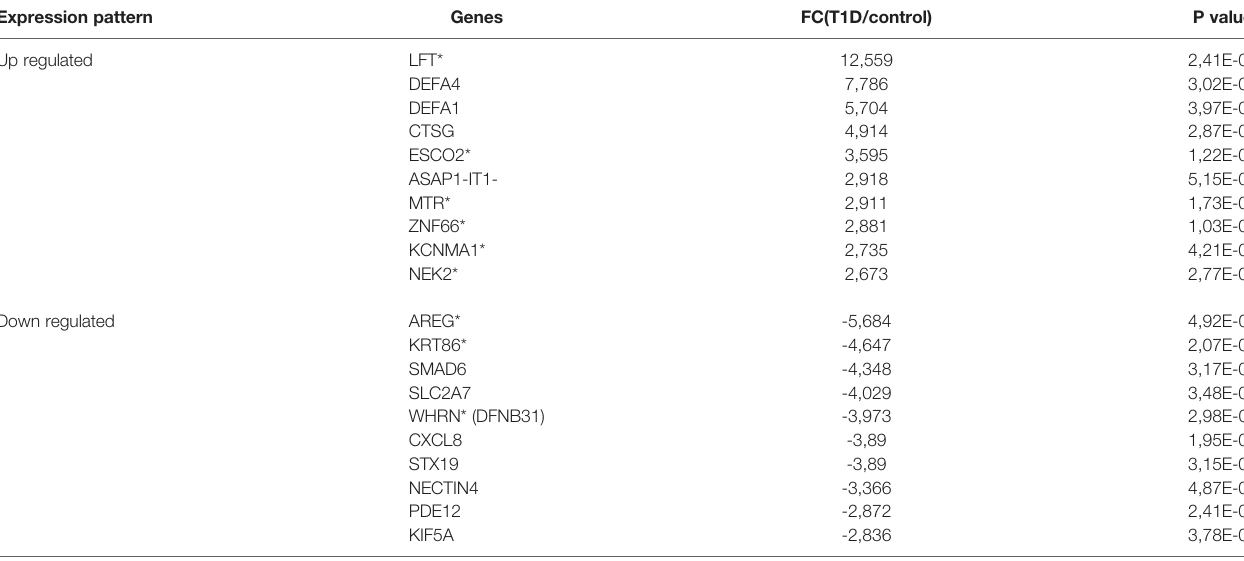
TABLE 2 | Expression (#) of top 10 up-regulated and down-regulated genes in patients with T1D group in comparison with health controls. Expression pattern